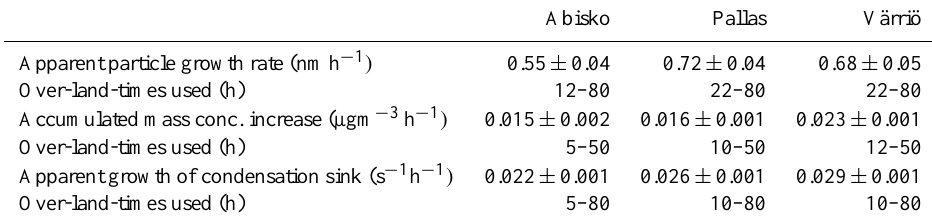
Fig. 5. Particle mode diameter (a) , integrated mass concentration (b) , number concentration (c) , and condensation sink (d) as a function of time the corresponding air mass has spent over land. Table 3. Increase rates of mode peak diameter, accumulated mass concentration, and condensation sink when air masses travel over land. Summer period (1.4–30.9) covered. See Fig.